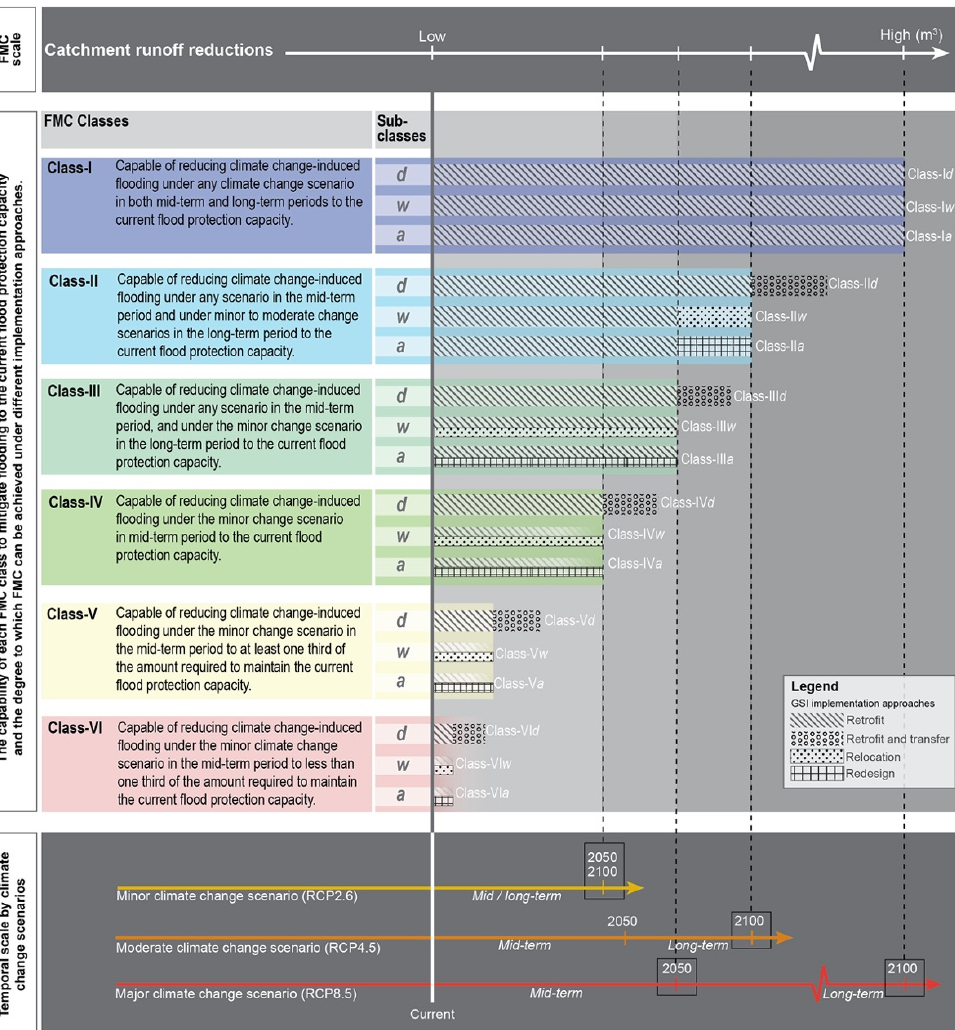
Figure 3. The FMC classification system groups SWM zones into six FMC classes according to their potential to reduce climate change-induced flooding to the current flood protection capacity associated with three temporal scales of different climate scenarios. Each class has three sub-classes indicating key limiting factors influencing the FMC of each zone ( d : the size of drainage area, w : the high groundwater level, and a : the potential GSI area). Hatched patterns present the maximum FMC which can be achieved through different implementation approaches. This figure is reprinted with permission from Muangsri et al. [21].